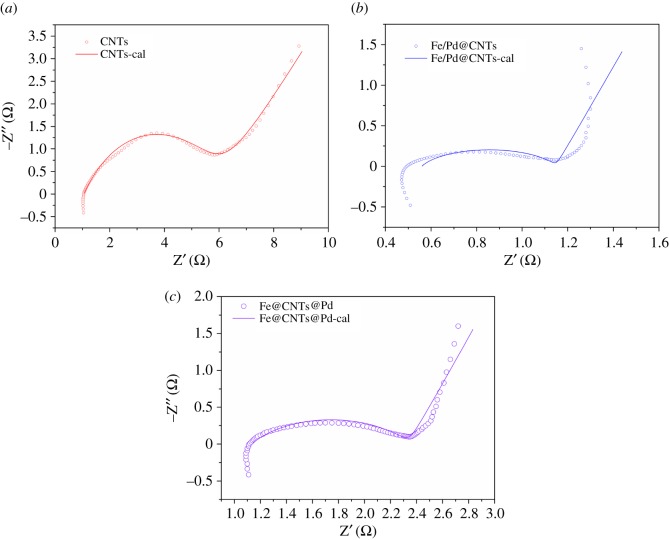
Nyquist plots of EIS fitting analysis of blank CNTs (a), Fe/Pd@CNTs (b), Fe@CNTs@Pd (c).